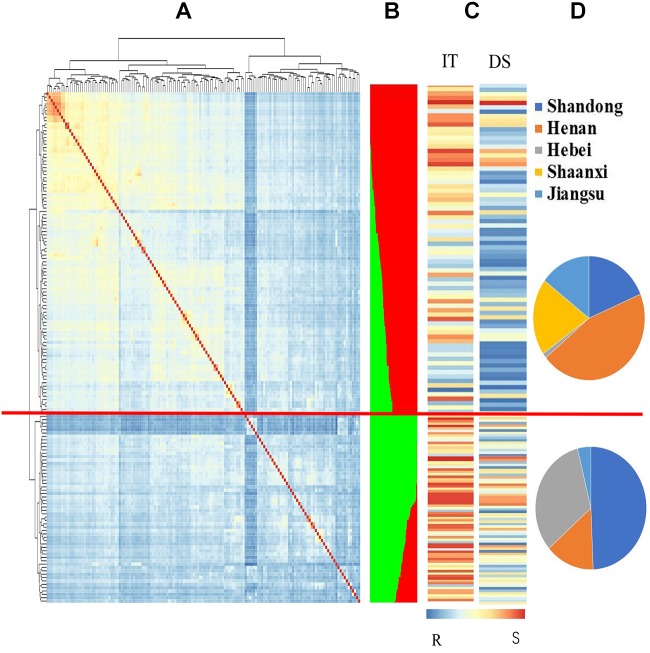
Relationship of population structure and genetic relatedness analysis of 152 Chinese Yellow and Huai River Valleys Wheat Zone landraces between population sub-clustering and stripe rust resistance. (A) Estimated the distance of hierarchical clustering for the accessions using Fast Ward grouping algorithm and heat map showing the kinship and phylogenetic relations. The same phylogeny was shown on the left and above the heatmap. Orange represents high kinship relations while blue colors shows continuous weaker relations. (B) Population structure summary plot (k = 2) of membership coefficients using STRUCTURE v.2.3.4. Each individual accession partitioned into colored segments, with the area of each segment representing the proportion. Two given sub-populations are represented: red Gp1; green Gp2. The red horizontal lines separated the 152 Chinese Yellow and Huai River Valleys Wheat Zone landraces into two subgroups according to structure membership coefficients. (C) The bar chart displayed IT and DS blue to white to red lines indicate reactions to Pst changed from resistance to intermediate to susceptibility to stripe rust. (D) Frequency of population structure subgroups in geographical regions of origin. From the top to the bottom, they are subgroups 1 and 2.